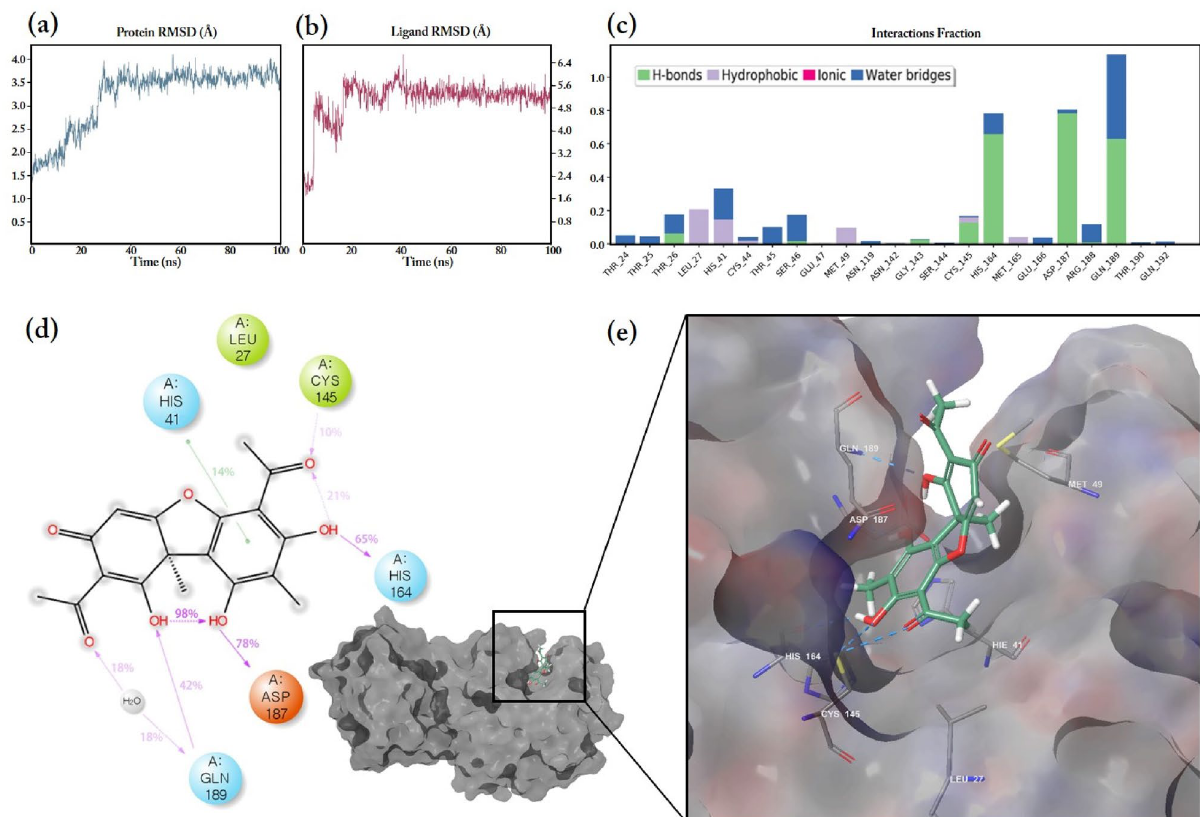
Figure 3. The MD simulation of (+)-usnic acid bound to the SARS-CoV-2 Mpro protein; ( a ) RMSD of the alpha-carbon of Mpro; ( b ) The ligand RMSD of (+)-usnic acid bound to Mpro, simulated for 100 ns; ( c ) The Mpro amino acid interaction with (+)-usnic acid showing H-bonds, hydrophobic interactions and water bridges; ( d ) The 2D % interaction illustration of (+)-usnic acid in tautomeric form; ( e ) The 3D illustration of (+)-usnic acid bound to Mpro showing interacting amino acids and hydrogen bonds.